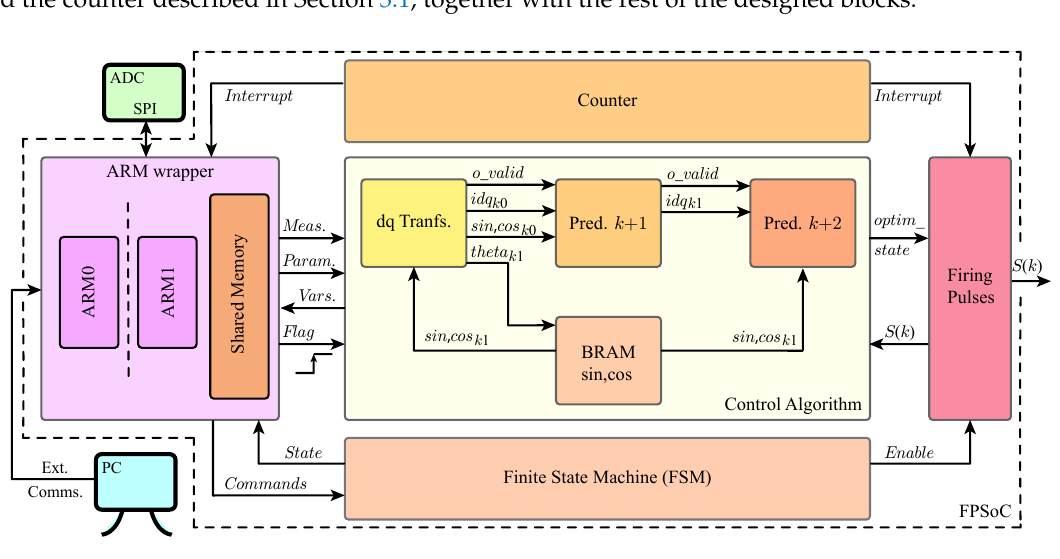
Figure 3. Block diagram of the proposed